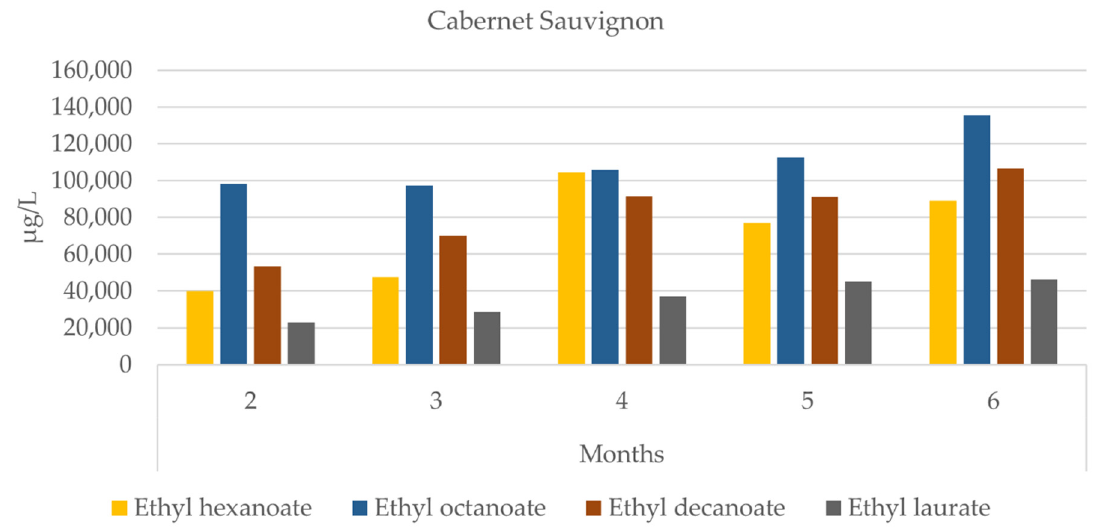
Figure 2. Changes in esters concentration in ‘ Syrah’ brandy during six month ageing in barrique oak barrels.